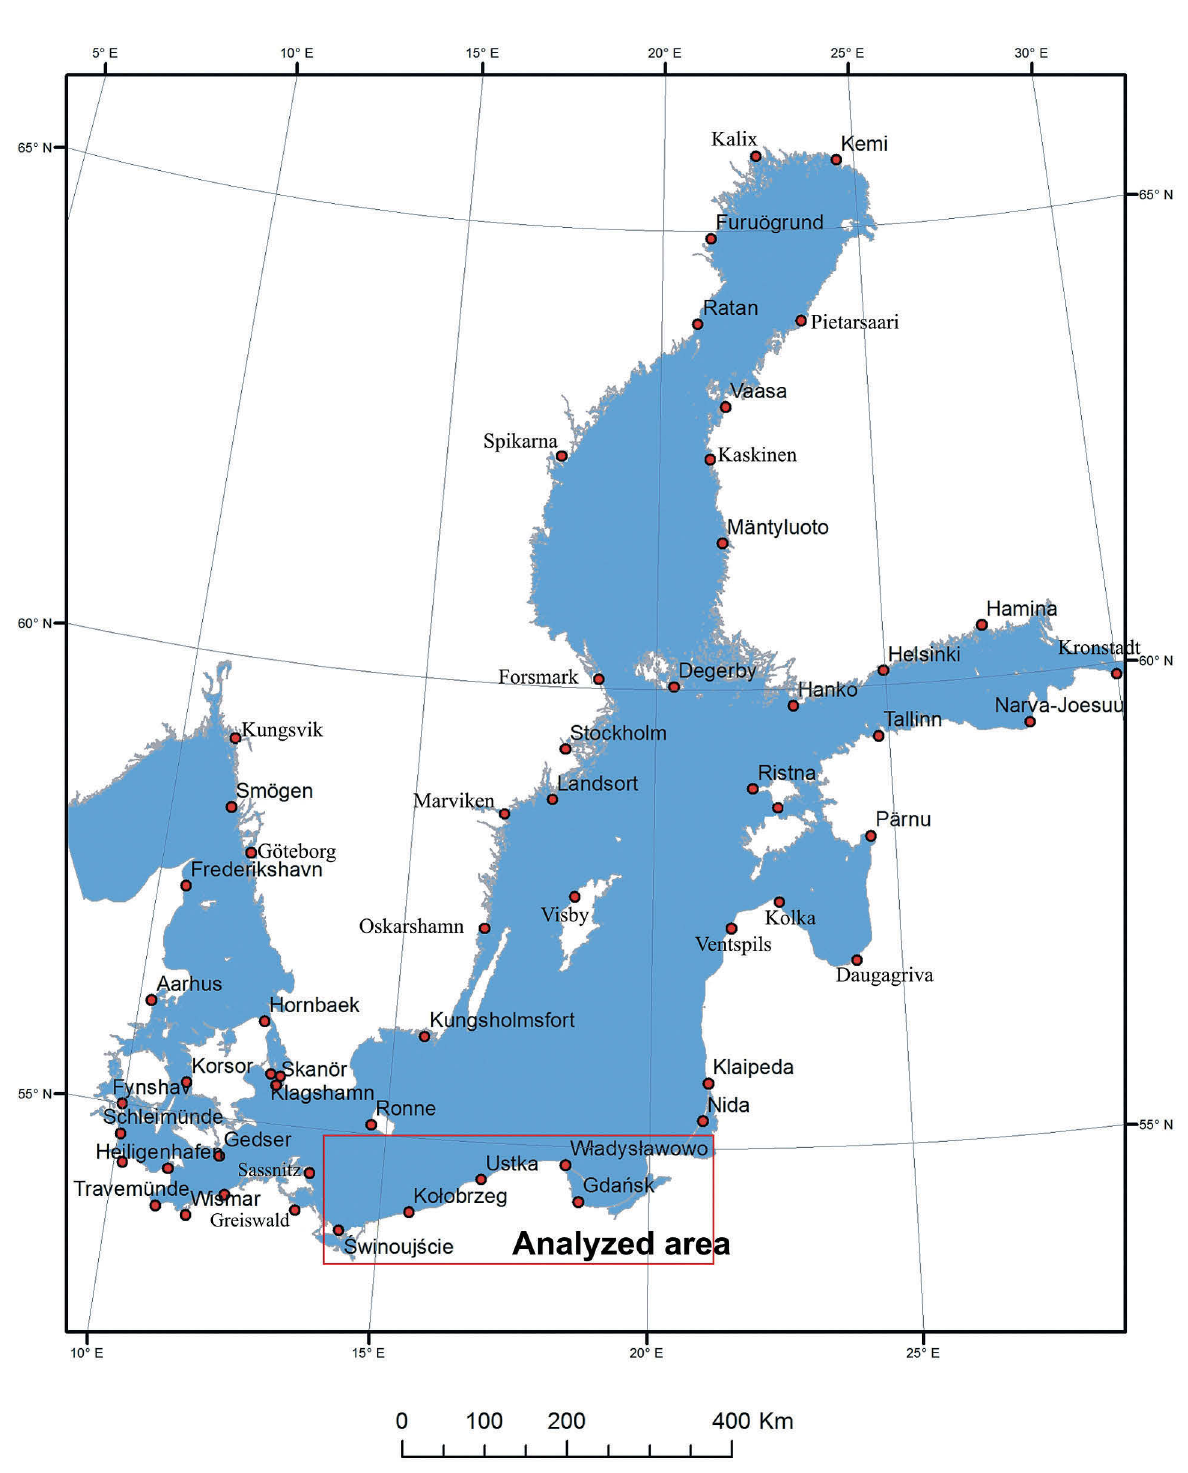
Fig. 1. Location tide gauge stations on the Baltic Sea